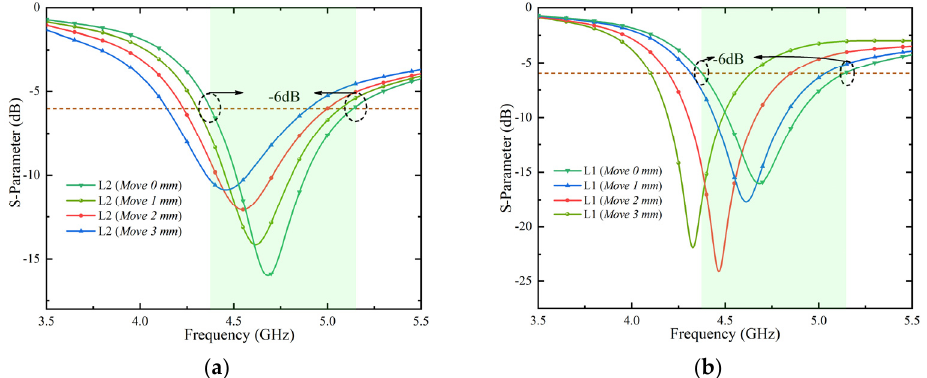
Figure 4. Simulate reflection coefficient of the antenna element. ( a ): With effects of L2 distance moved and ( b ): with effects of L1 distance moved.